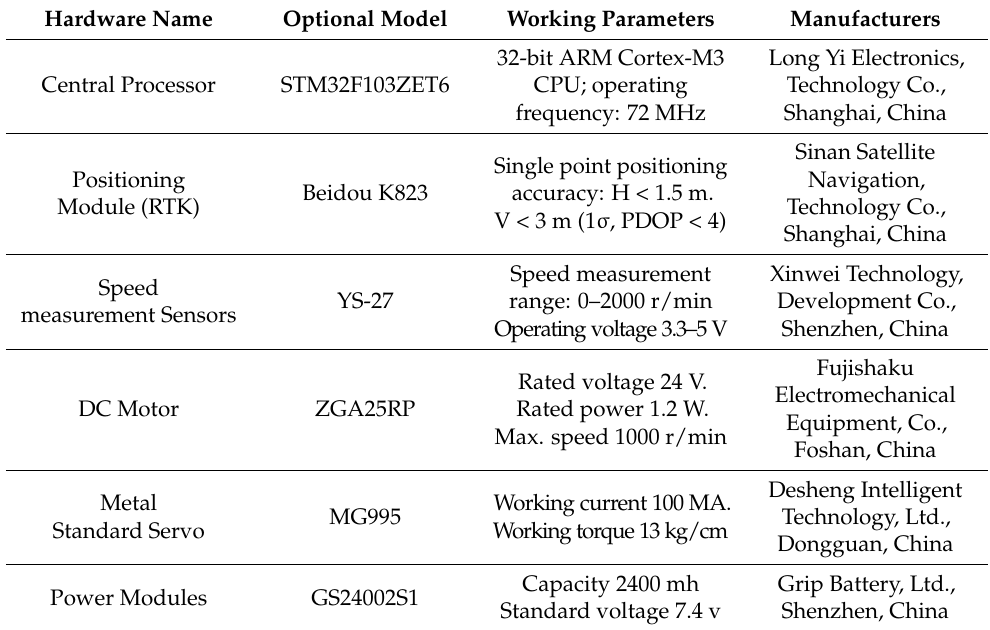
Table 1. Hardware module selection and working parameters of variable fertilization control